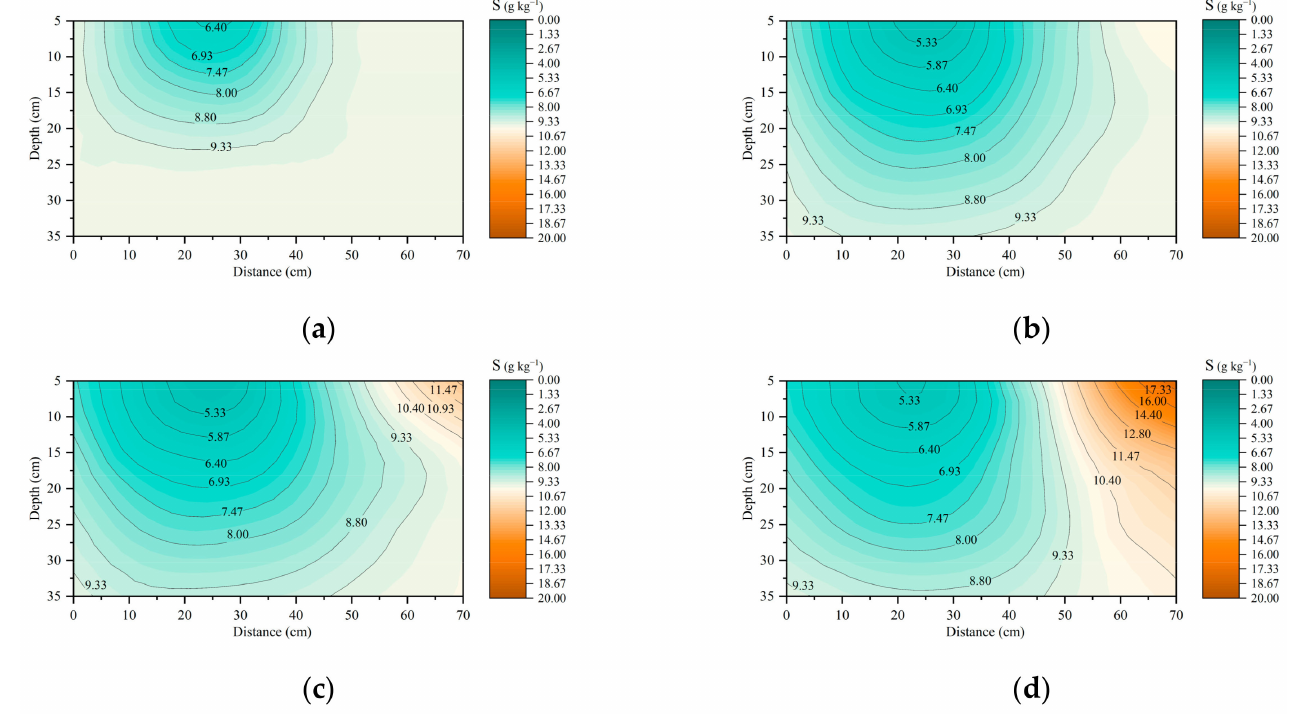
Figure 7. Simulated contours of soil salinity under W1, for ( a ) the middle of the first irrigation; ( b ) the middle of the third irrigation; ( c ) the middle of the fifth irrigation; ( d ) at the end of